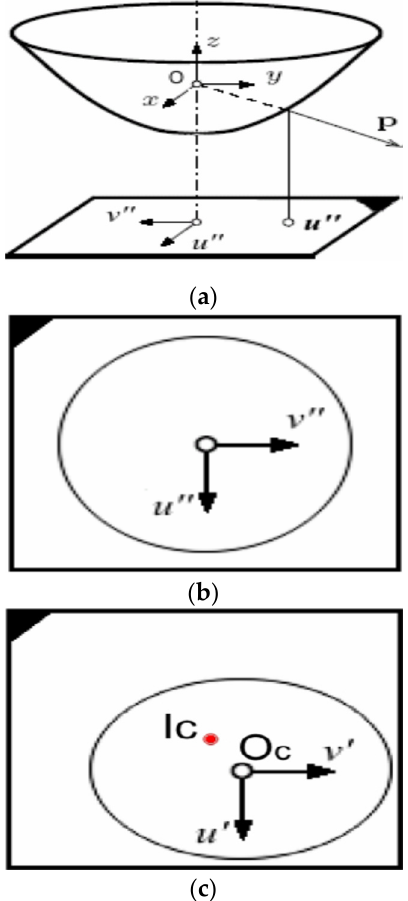
Figure 2. Fish-eye camera model and coordinate system. ( a ) Camera model. ( b ) Imaging plane coordinate system. ( c ) Image coordinate